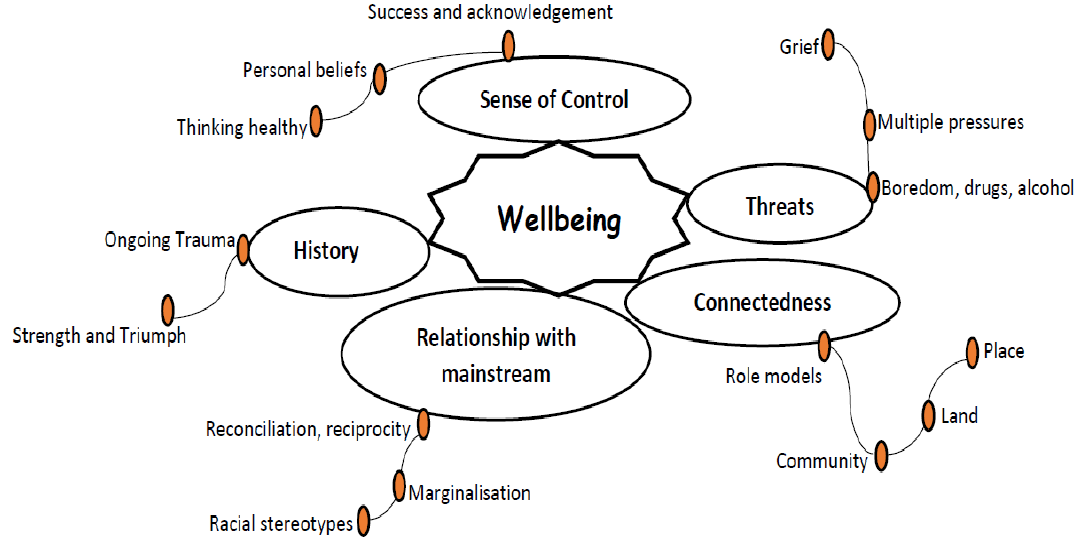
Figure 2. Holistic model of Indigenous Wellbeing—"Our Wellbeing” [14,15].